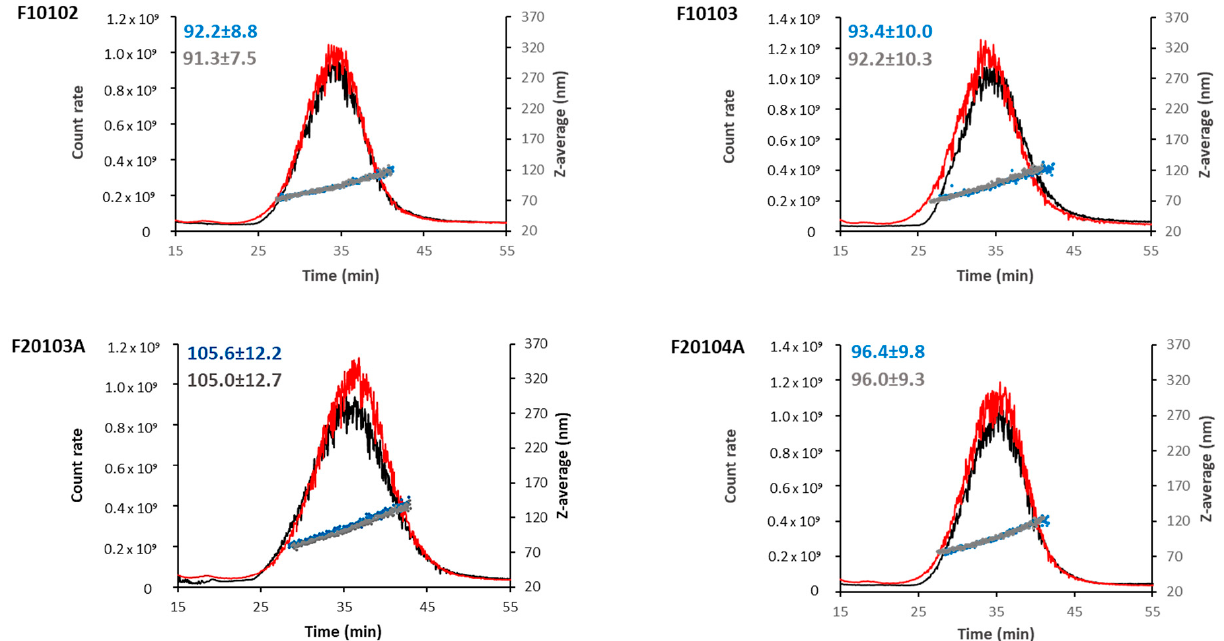
Figure 3. AF4-DLS measurements of selected liposomes in PBS (black lines and blue dots) or PBS supplemented with 10% human serum (red lines and grey dots). The elugram of flow mode DLS (scattered intensity and size vs. elution time) are reported for one representative measurement for each selected liposome and condition. Scattering intensity peaks (lines) and hydrodynamic diameters (dots) by DLS are shown. Hydrodynamic diameter values, measured in PBS or in serum, are reported (blue and grey respectively).